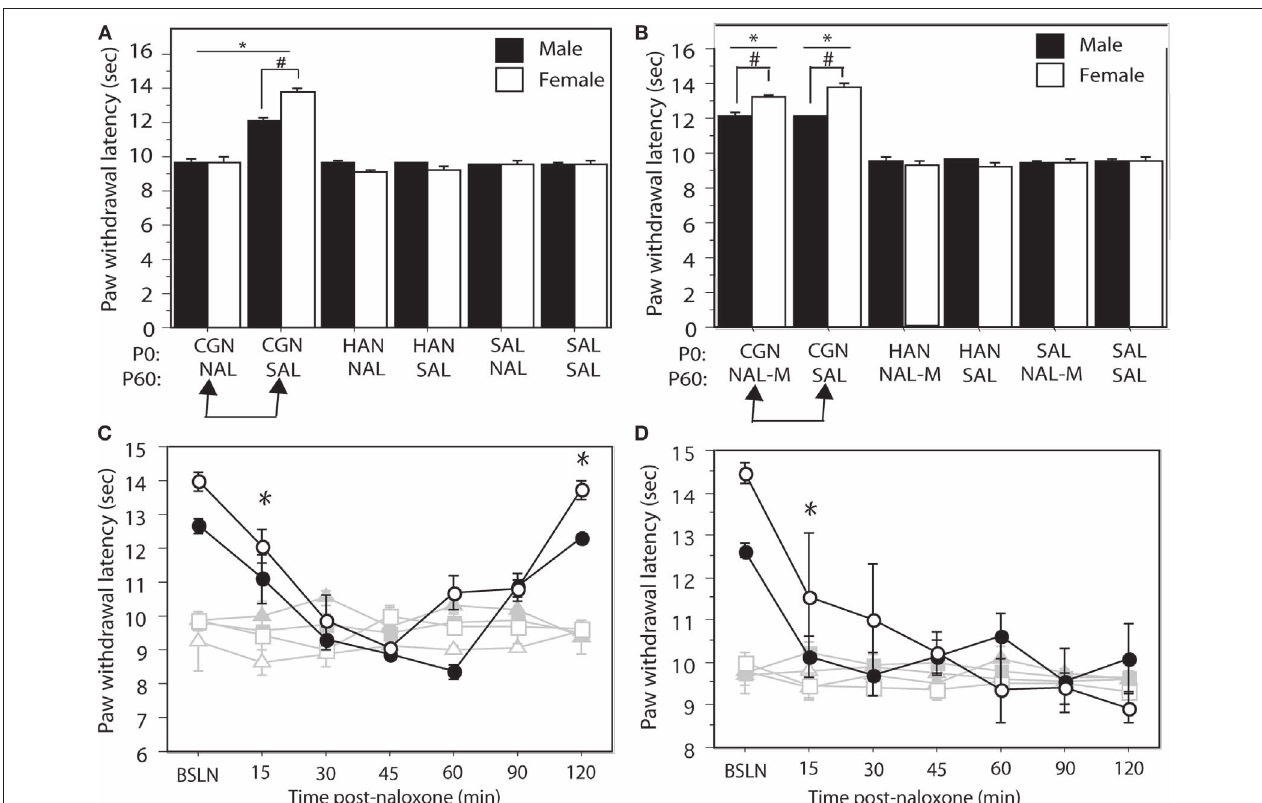
SAL/SAL) and handled (HAN/NAL-M and HAN/SAL) controls. (C) Neonatally injured males ( (cid:122) ) and females ( (cid:123) ) displayed signifi cantly reduced PWLs during the 120 min following i.c.v. or (D) intra-PAG administration of naloxone HCl compared to handled males ( (cid:83) ) or females ( (cid:85) ) and saline males ( (cid:132) ) and females ( (cid:133) ). N = 6–8 rats per group/per sex. In panels (A) and (B) : * denotes signifi cant main effect of treatment; # denotes signifi cant main effect of sex; in panels (C) and (D) – * indicates that PWLs for injured animals (collapsed across sex) were signifi cantly different from controls. Error bars represent